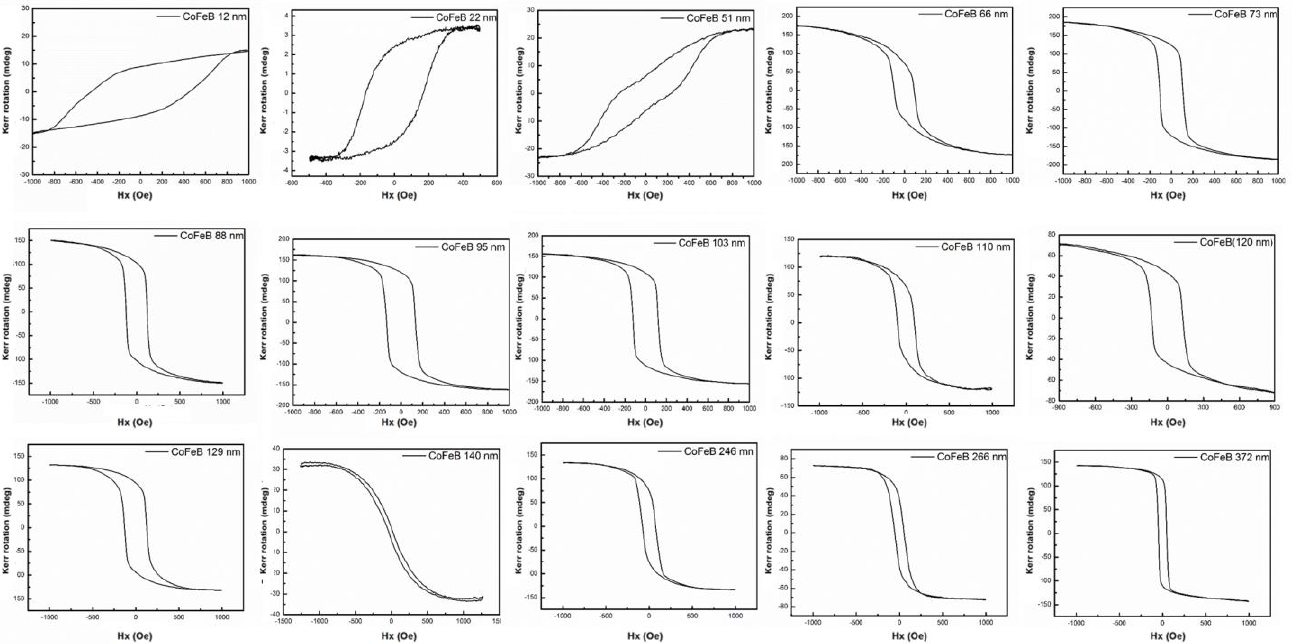
Figure 5. s-polarization L-MOKE hysteresis loops for CoFeB/AAO thin films with CoFeB thicknesses from 12 to 372 nm (the CoFeB thickness of each film sample is labeled in the upper right of each subfigure), excited at a laser wavelength of 660 nm and an inducing angle of 45°.